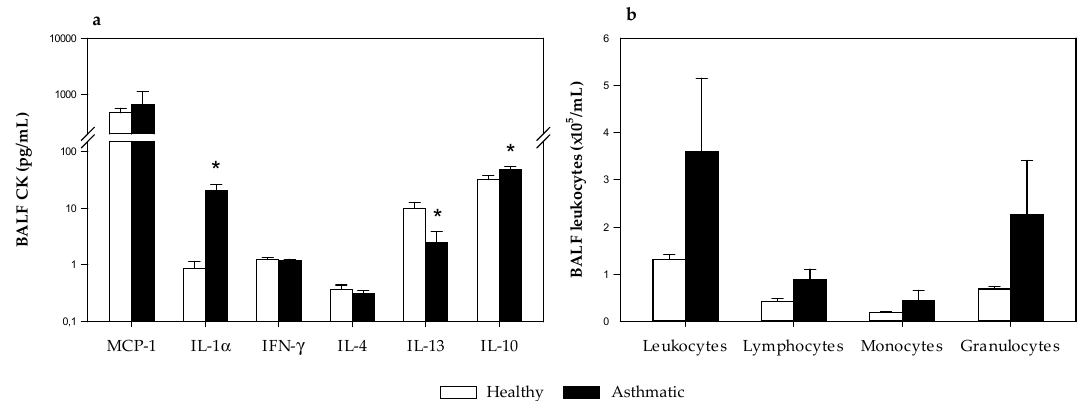
Figure 7. ( a ) Cytokine concentration and ( b ) leukocyte content in bronchoalveolar lavage fluid (BALF) samples obtained 24 h after the i.n. challenge in healthy rats (H, white bars) and asthmatic rats (A, black bars). Results are expressed as mean ± standard error ( N = 9). Significant di ff erences: * p < 0.05 vs. healthy animals.